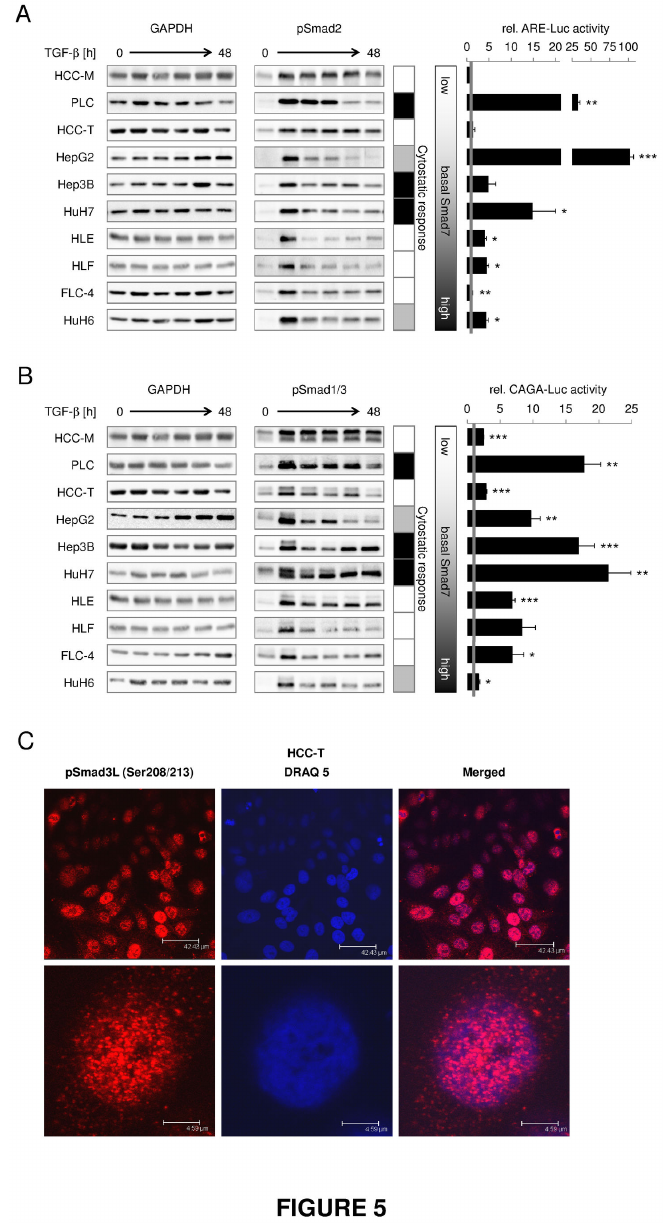
Figure 5. While Smad2 phosphorylation duration correlates to TGF-β and Smad7 expression, cytostatic responsiveness relates to CAGA-reporter-activation. HCC cell lines were treated with 5 ng/ml TGF-β for 0, 1 (3),, 7, 24 and 48 h. (A) Left side: Western blot analysis of Smad2 phosphorylation and GAPDH expression. Right side: To evaluate TGF-β dependent transcriptional activity of Smad2, cells were transfected with plasmids carrying a luciferase gene under control of the activin response element (ARE) and additionally with a FAST-1 expression construct. Luciferase activity of cells treated with 5 ng/ml TGF-β for 9 h was correlated to untreated control samples. (B) Left side: Western blot analysis of Smad1/3 phosphorylation (1: upper/3: lower band); loading control GAPDH. Right side: TGF-β dependent transcriptional activity of Smad3 was evaluated 9 h after TGF-β treatment in cells infected with an adenovirus carrying a luciferase gene controlled by a CAGA response element. Treated samples were correlated to the corresponding untreated control. In the table, cell lines marked as black, show TGF-β induced cell death and growth inhibition whereas cells marked as grey mainly react with the latter one. The gradient from white to black displays increasing basal Smad7 expression levels. (C) Immunofluorescent detection of linker phosphorylated Smad3 in uninduced HCC-T cells. Red fluorescence indicates nuclear localization of pSmad3L. Blue staining indicates nuclei stained with DRAQ5. Significant differences are indicated as * p < 0.05, ** p < 0.01 and *** p < 0.001 (Student’s t test). doi: 10.1371/journal.pone.0072252.g005 PLOS ONE |